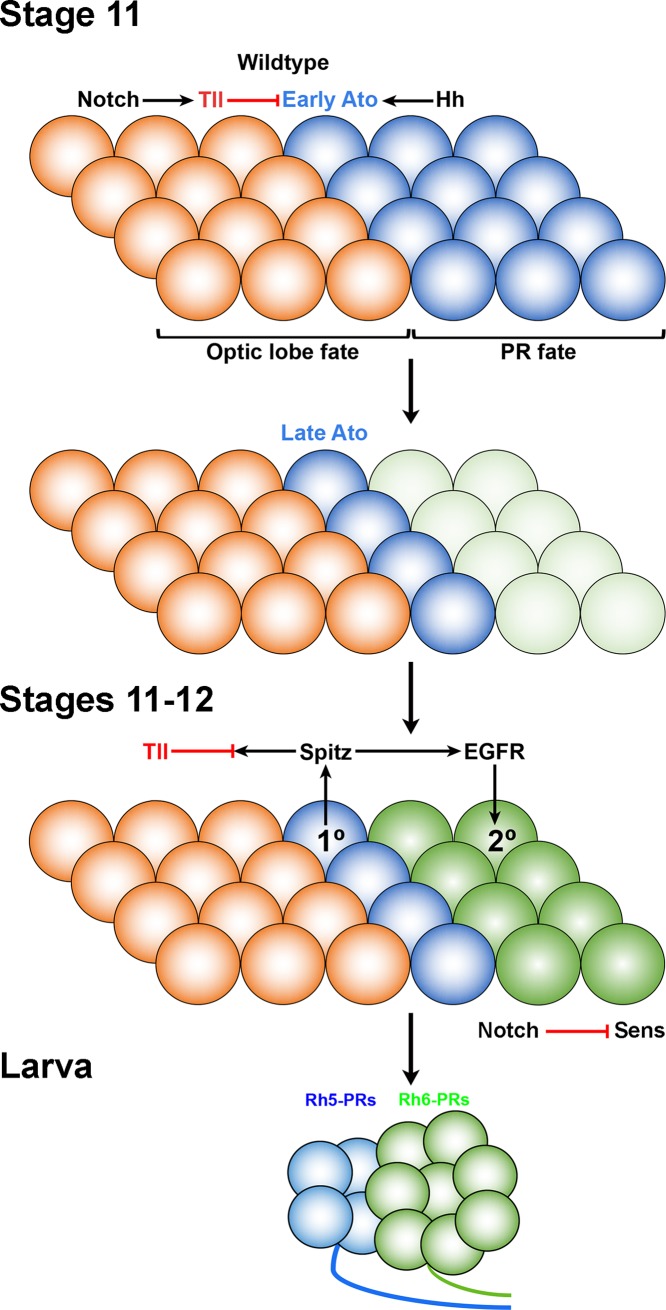
Model of neurogenic optic placode patterning and control of cell fate choices in the wildtype embryo.Schematic representation of neuroepithelial patterning and regulation of optic lobe neuroepithelium versus PR cell fate in the optic placode in Drosophila. Regulation of ato and tll expression by Hh and Notch signaling in the embryo is required for the acquisition of cell fate identity in the primordium of optic lobe and larval eye. Temporal expression of ato (early and late ato) in the larval eye primordium marks PR cell fate whereas tll expression in the optic lobe primordium marks optic lobe neuroepithelial cell fate. Tll represses ato expression and maintains a balance between PR and non-PR cells in the optic placode. Hh signaling promotes Ato-dependent primary PR precursor specification and controls cell number in the optic placode possibly by regulating cell proliferation. Notch activity maintains optic lobe neuroepithelial cell fate in the optic lobe by indirectly repressing ato activity in a Tll-dependent manner. In addition, at later stages Notch represses Sens and thereby promotes secondary PR precursor formation at the expense of primary PR precursors.